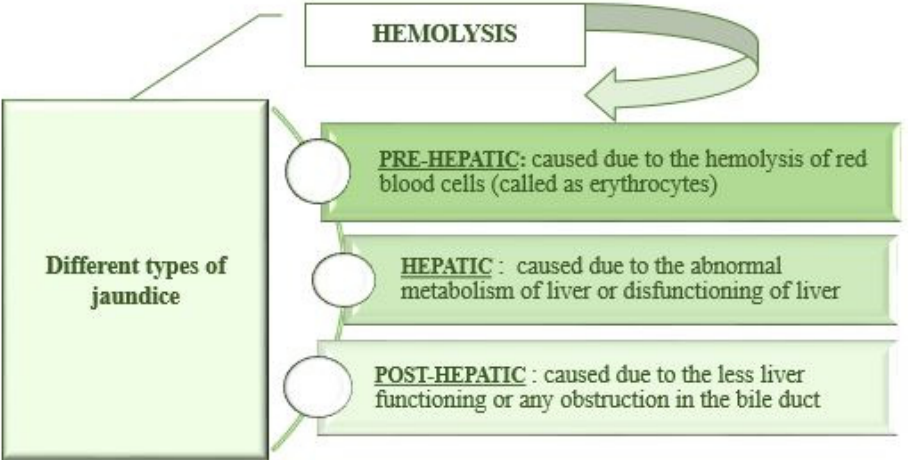
Figure 2. Types of jaundice according to its pathophysiology